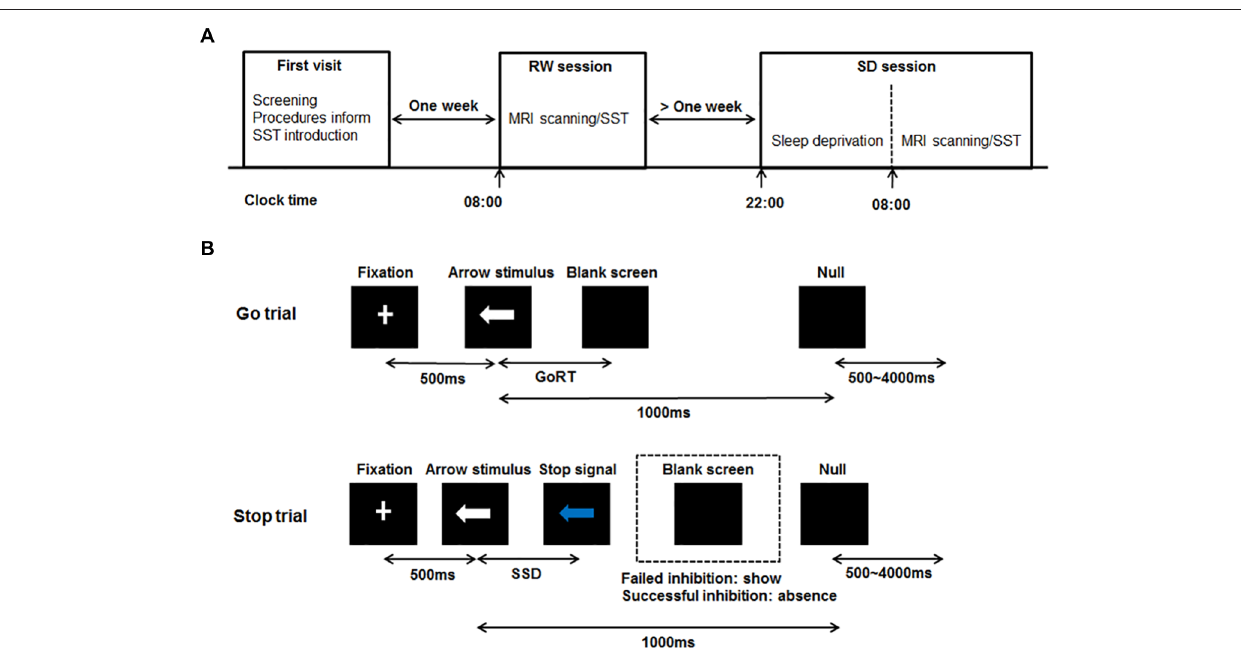
FIGURE 1 | Schematic diagram of the experimental procedure and the stop-signal task (SST). (A) Schematic showing the order of the experimental procedure. For the first visit, subjects underwent the screening process, were informed of the experimental procedures and were given instructions about the SST. After 1 week, subjects administered the simultaneous magnetic resonance imaging (MRI) scanning/SST twice at 8:00 am in the second visit and third visit respectively, once after RW and once after 24 h of SD. The RW and SD sessions were administered in a randomized, cross-over fashion with at least 1 week apart. For the SD session, subjects were monitored in the laboratory from 10:00 pm to 8:00 am to prevent them from falling asleep. (B) Schematic of the SST including Go trial and Stop trial. All trials started with 500 ms white cross fixation in the center of the black background screen. Then, a left- or right-pointing arrow stimulus was displayed on a computer screen. On Go trial, subjects were instructed to press the button as soon as possible within 1000 ms. If subjects responded, the arrow stimulus disappeared, and the blank screen was shown. The interval between the arrow stimulus and blank screen was the GoRT. On Stop trail, subjects were instructed